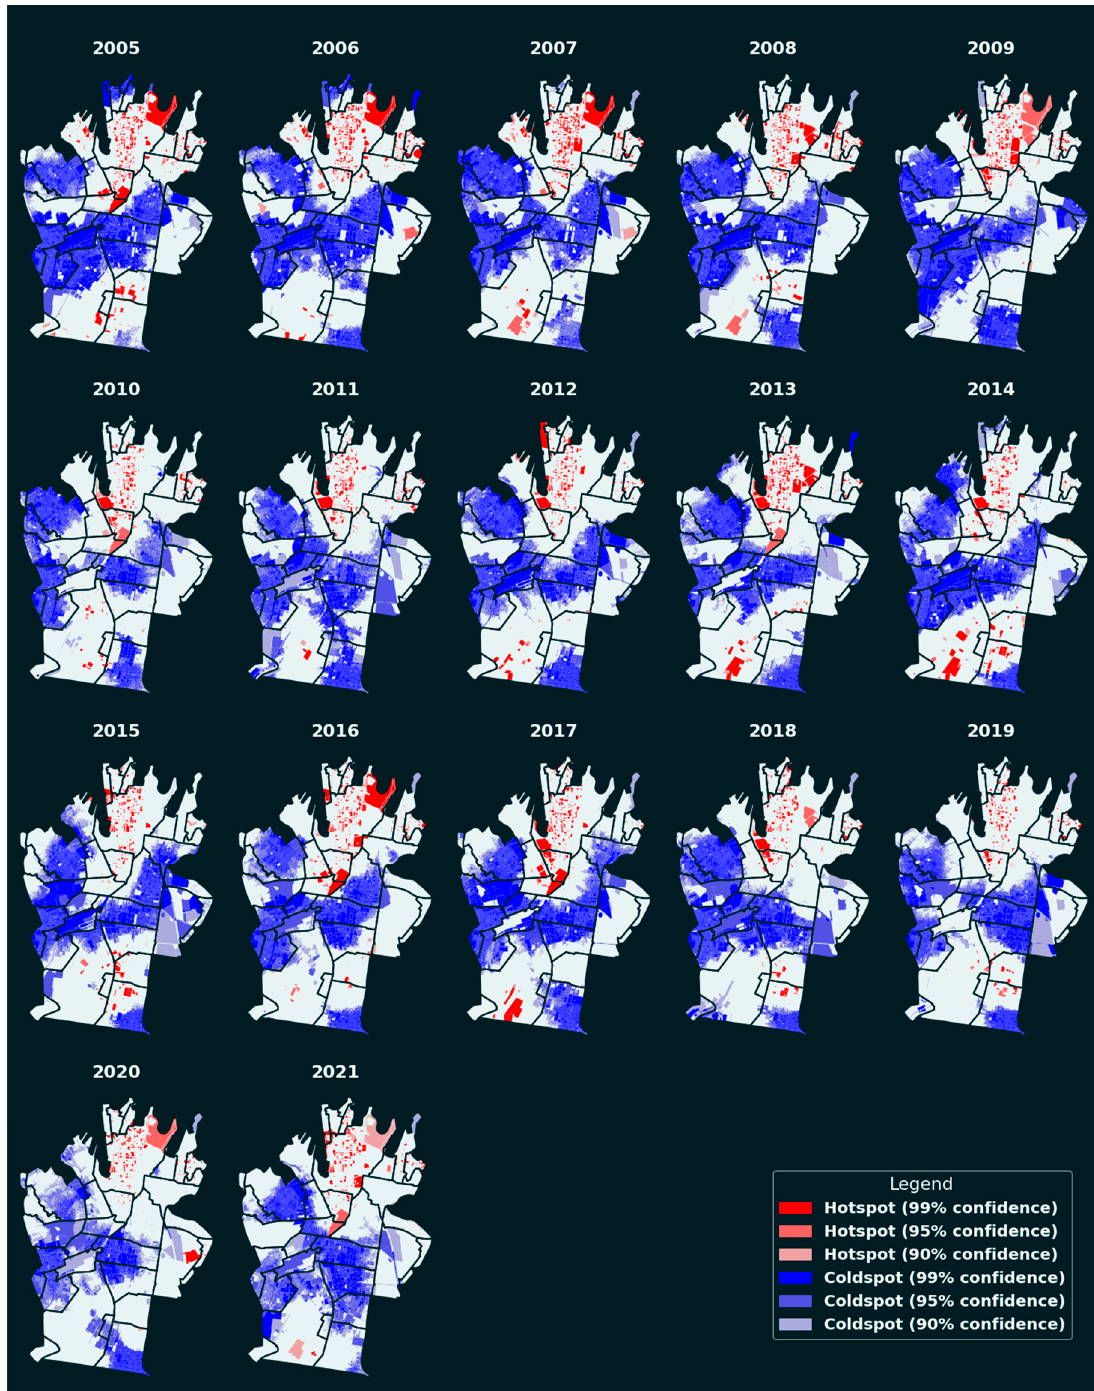
Figure 22. Development hot and cold spots by year, excluding minor DAs (DAs categorised as ignored earlier) (2005–2021).